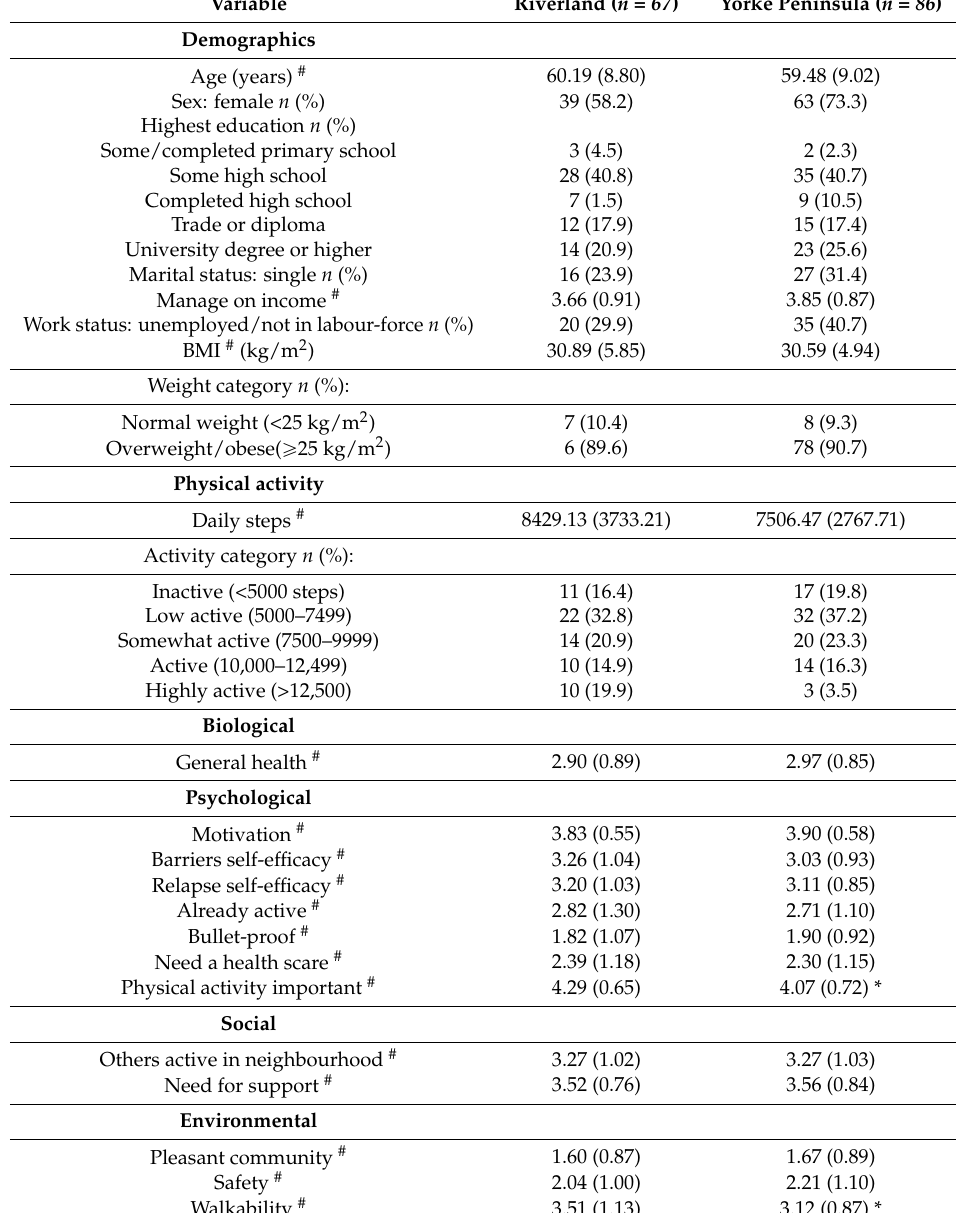
Table 1. Sample descriptive characteristics by